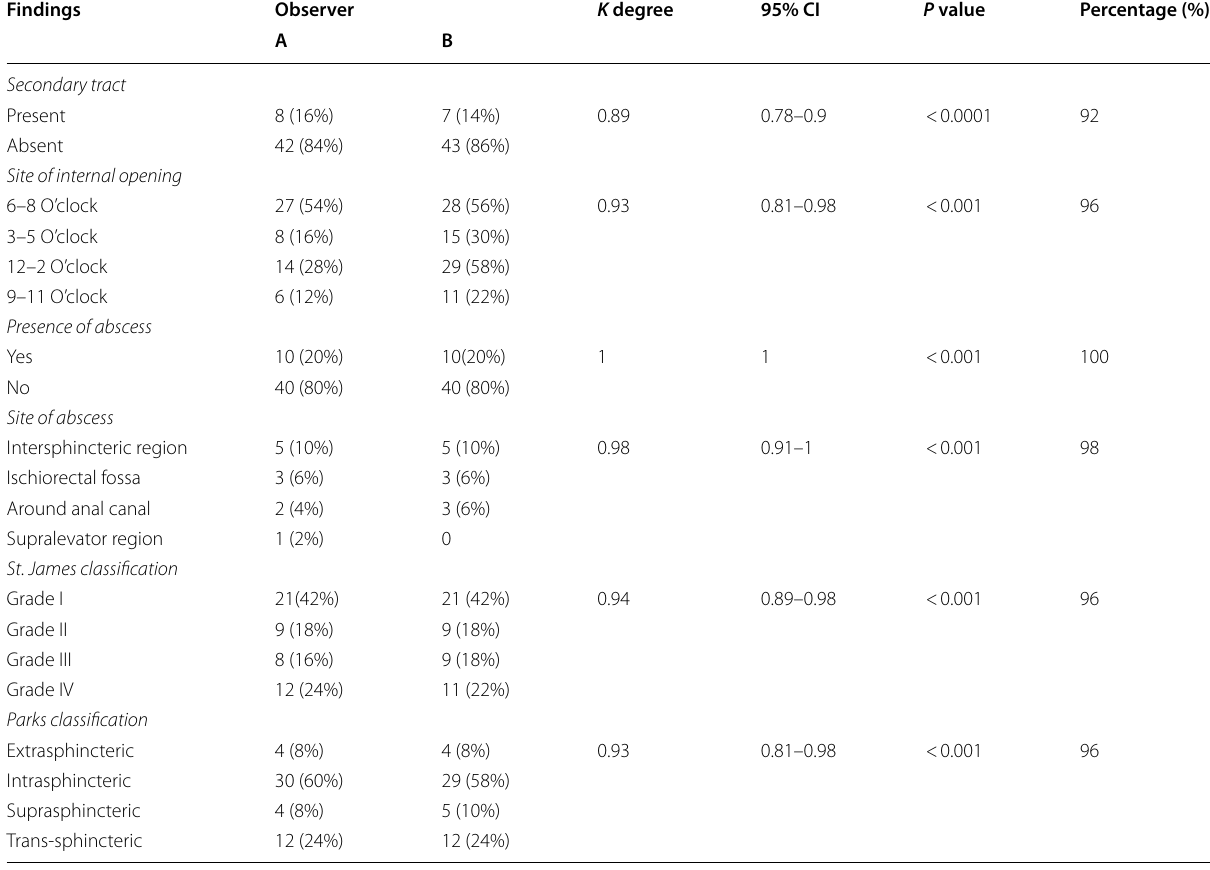
Table 10 Interobserver agreement between observer A and B for findings in MRI